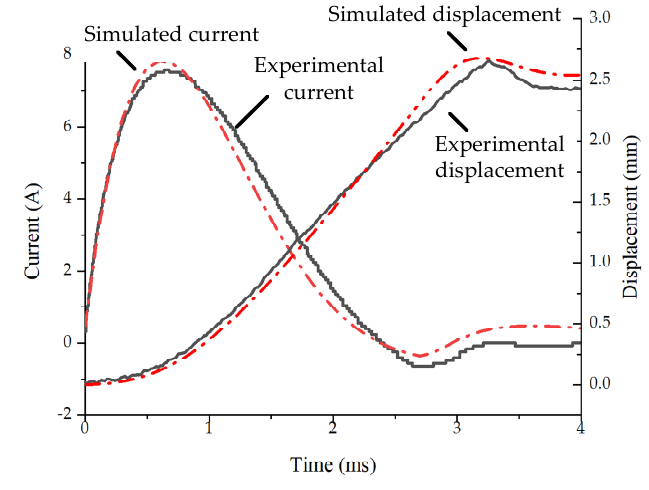
Figure 8. Comparison of simulation and experiment.